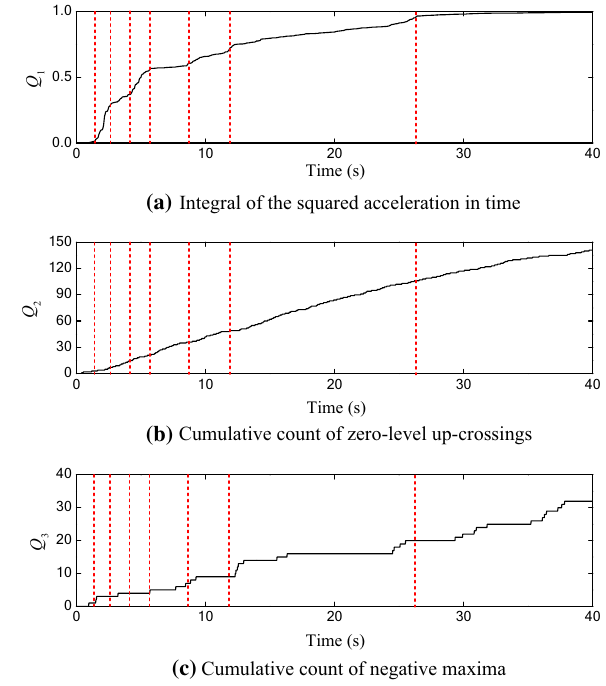
Fig. 9 Representation of the variance, predominant frequency, and bandwidth of the given acceleration